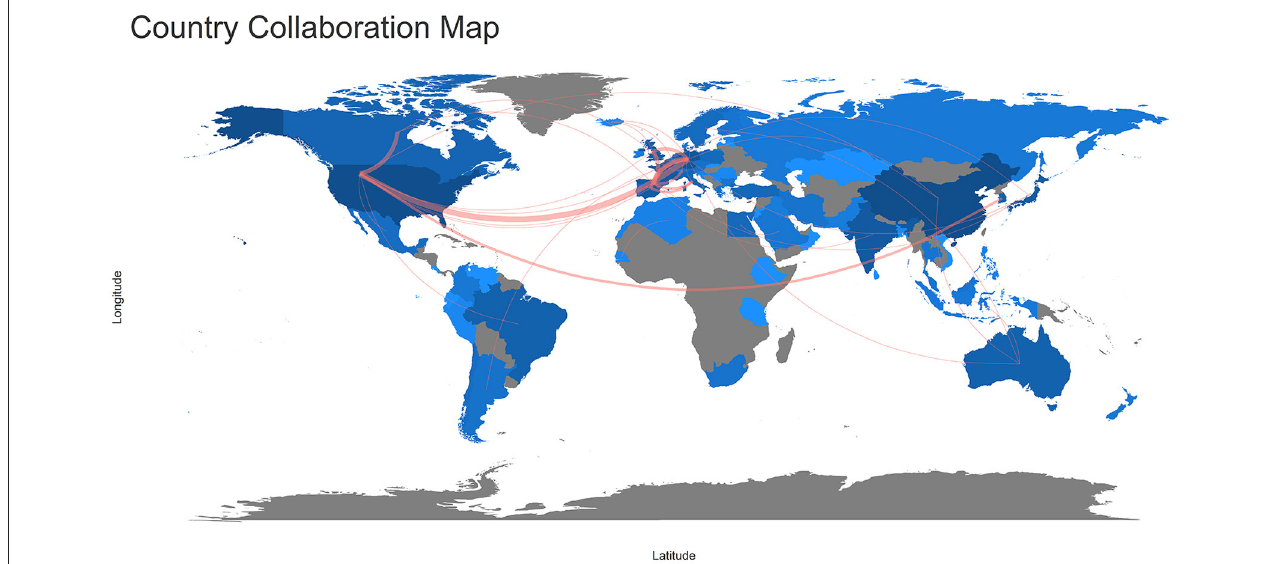
FIGURE 2 | Country collaboration map of microalgae-fungi consortia publications.